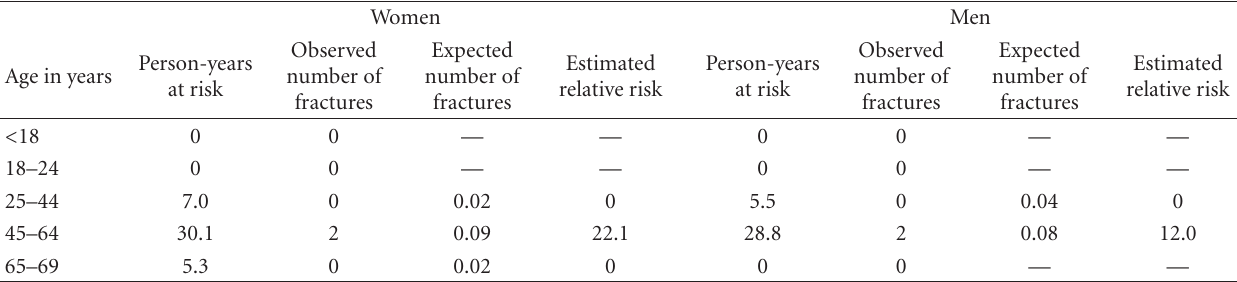
Table 4: Age- and gender-specific fracture incidence rates in kidney/liver transplant recipients.